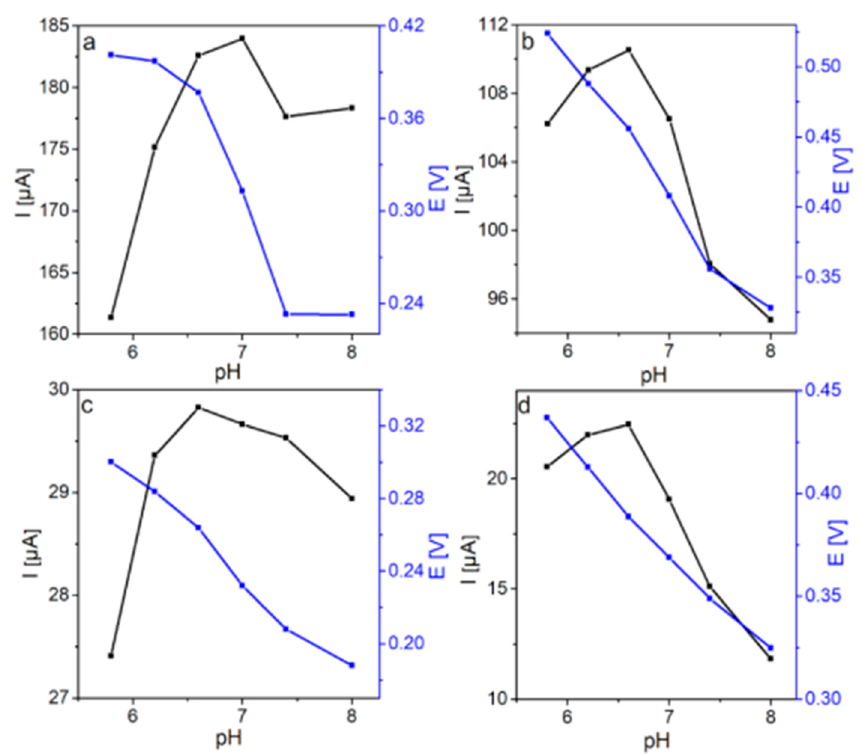
Figure 5. Dependence of anodic peak current and potential on the pH for ( a ) GCE / FSG and ( c ) GCE / PFSG during DA oxidation and ( b ) GCE / FSG and ( d ) GCE / PFSG during UA oxidation.